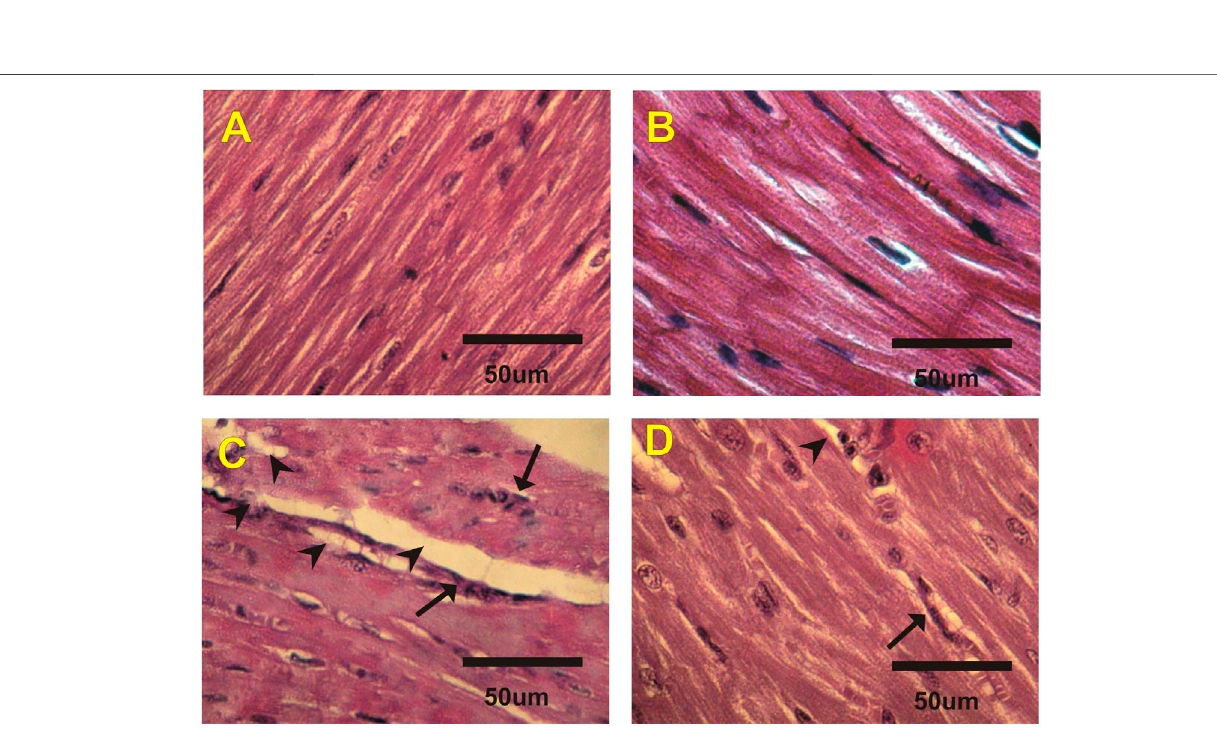
Frontiers in Pharmacology |